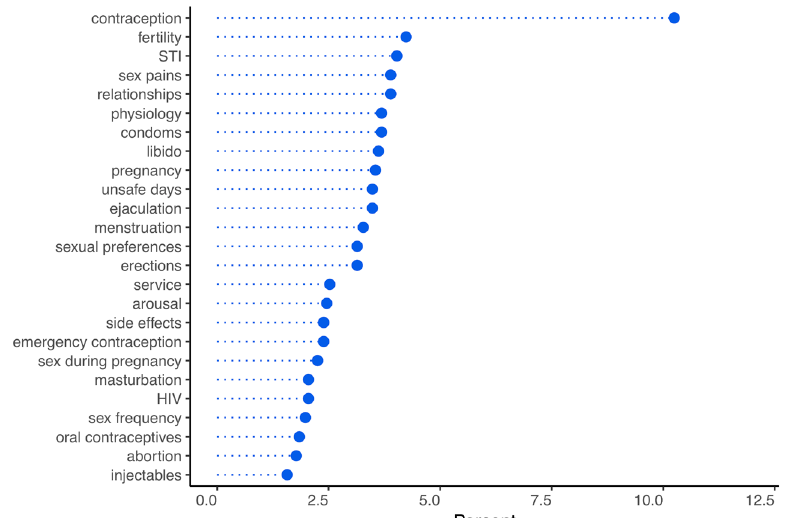
Figure 11. Distribution of topics that appeared most frequently in multiple-topic conversations, top 25 topics shown. STI, sexually transmitted infection; HIV, human immunodeficiency